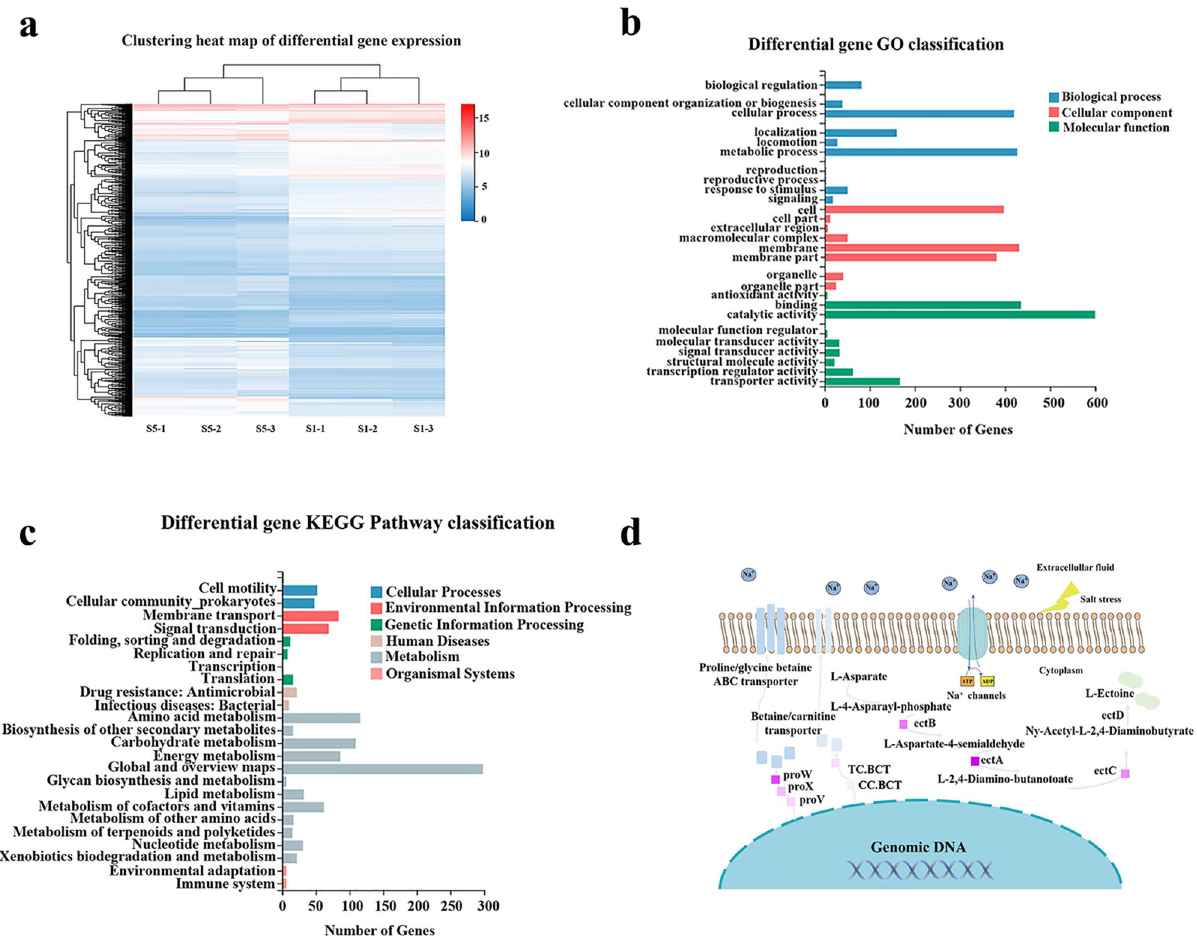
Fig. 1 Transcriptome data analysis. a The heat map, based on hierarchical analysis using the log2 (5%/1%) for each gene at two groups (5 and 1%), depicted that 1,596 genes were detected out. The colors were ranging from blue to red, representing the values of log2 (5%/1%). b Signi fi cantly enriched GO categories for the genes with fold changes in Log2 ≥ 4. c Differential gene KEGG pathway classi fi cation for the genes with fold changes in Log2 ≥ 4. d Proposed halophilic mechanism of strain Vmax based on the transcriptome